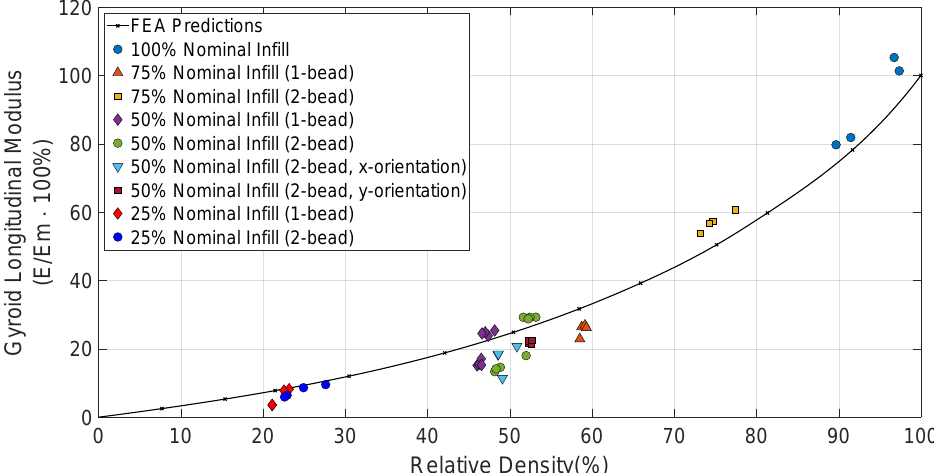
Figure 11. Experimental results vs. finite element analysis (FEA) predictions for elastic